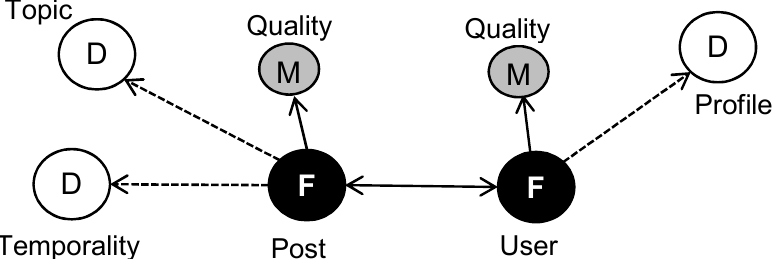
Figure 1. Summary of the multidimensional model for Twitter streams analysis. We follow the usual notation for multidimensional models: (D) for dimensions, (F) for facts and (M) for metrics. Dotted lines indicate that dimensions are dynamically created from the streamed data.